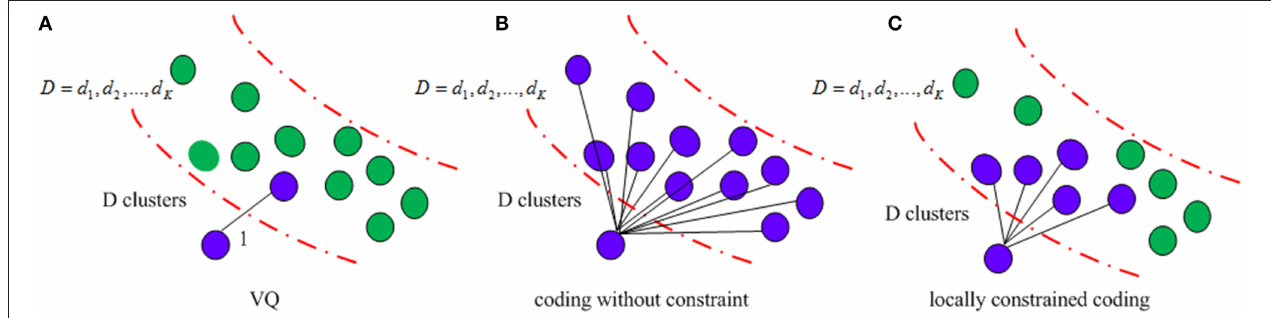
FIGURE 4 | Illustration of the clustering method (A) VQ; (B) coding without constraint; (C) locally constrained